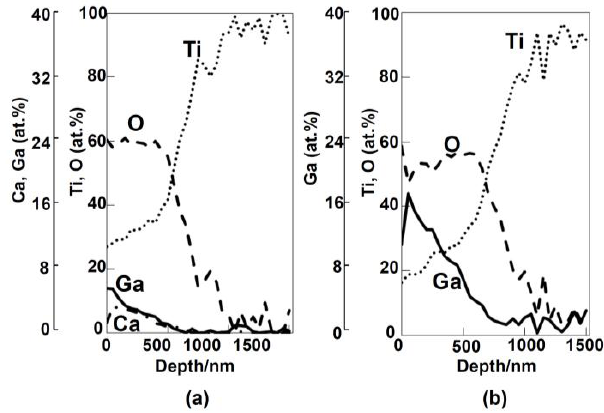
Figure 5. XPS depth profiles of Ti that was initially soaked in NaOH solution and then subjected to ( a ) 100Ca + 0.05Ga and ( b ) 100Ga treatment followed by heat and water treatments.